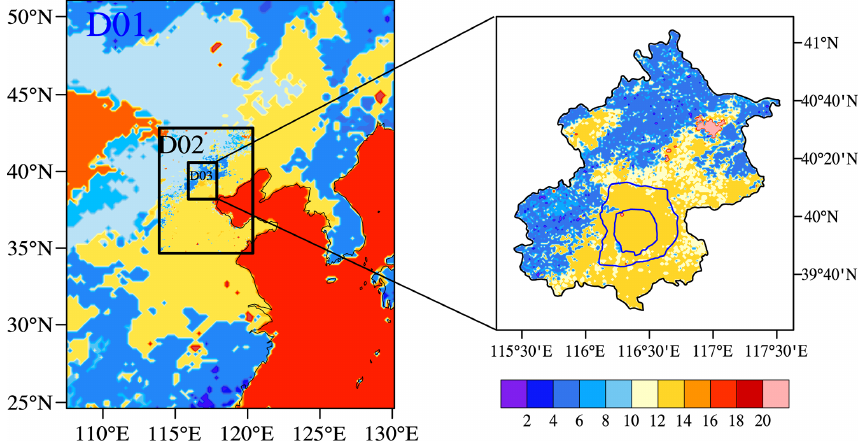
Figure 3. Simulated area, land use, and land cover in